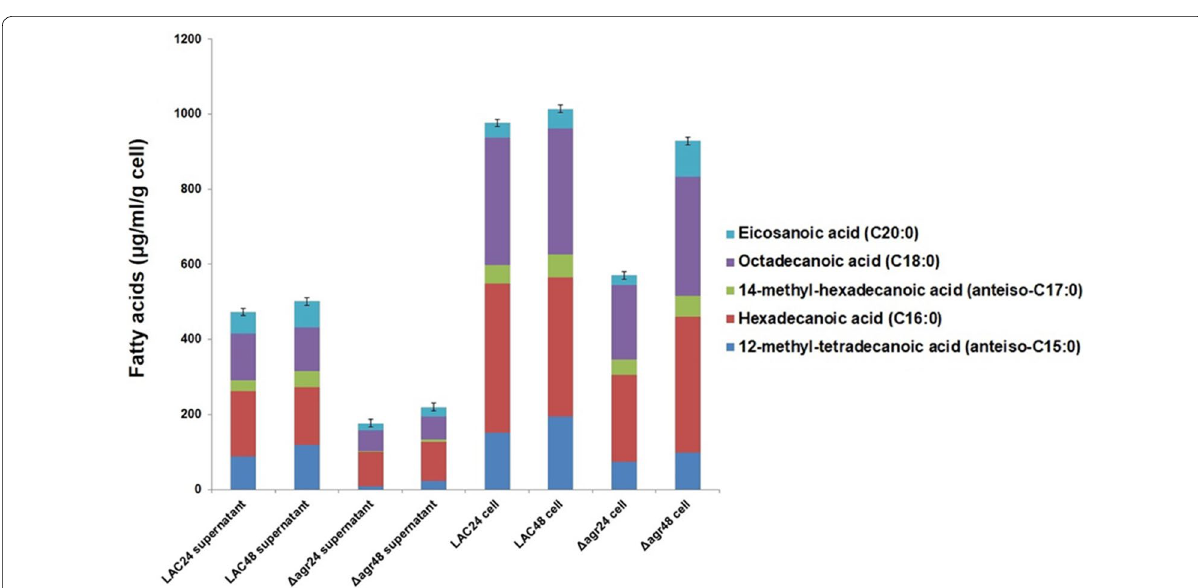
Fig. 2 Comparison of total fatty acids and supernatant fatty acid profiles between the LAC and Δ agr mutant strain. Supernatant and cell biomass samples were taken separately at 24 h and 48 h. 24 and 48 following strain name indicate the time point of sample collected. The error bars represent the standard deviation of three